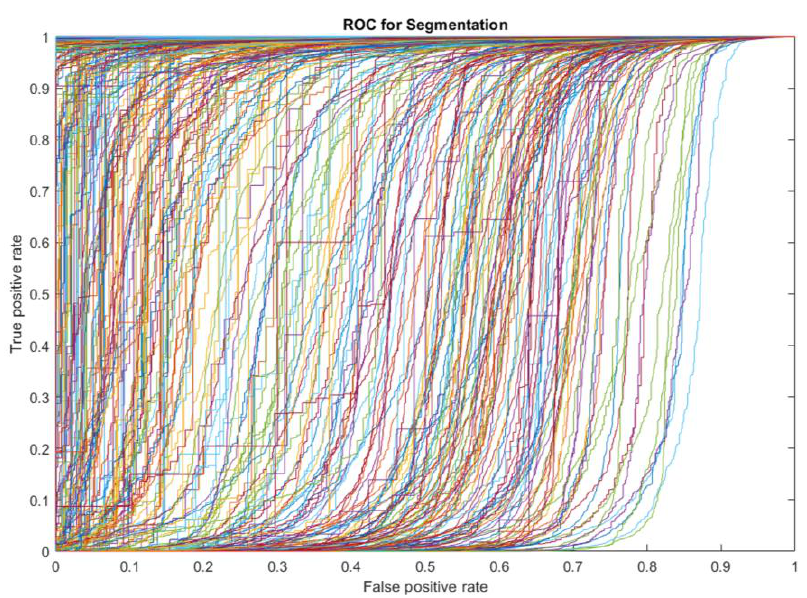
Figure 12. The ROC curve of a CNN network cancer tumor.